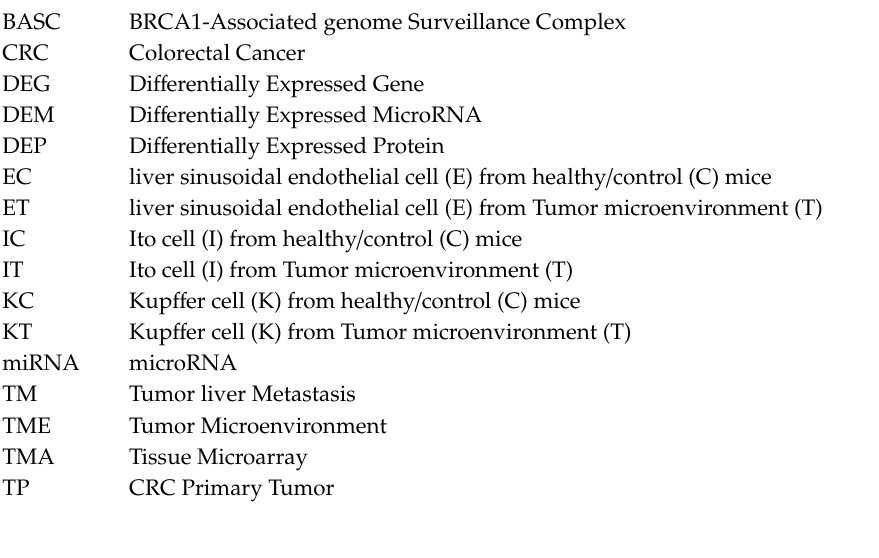
Short Summary: Integrative omics study of expression of genes, miRNAs and proteins in three types of mouse liver cells from the TME of CRC liver metastasis revealed that Brca1 is simultaneously up-regulated in all the TME cells. Further immunohistochemical analysis in human liver metastases showed that BRCA1 protein is co-localized in the three cell types from 81.8% of synchronous metastases from Stage IV